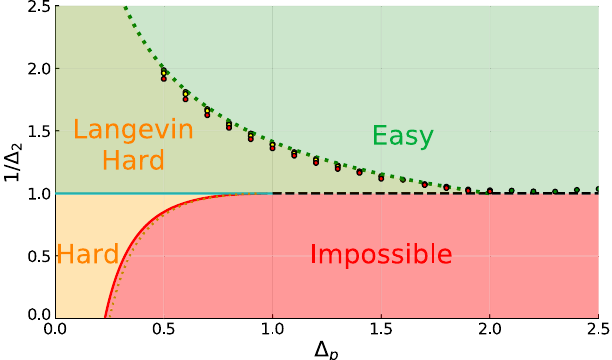
FIG. 15. Estimated divergence point Δ (cid:1) 2 at fixed Δ p ¼ 3 a function of the initial condition 10 − 4 . The vertical axis is in the linear scale, while the horizontal axis is in the log scale. We observe that the dependence of estimated divergence points on the initial condition is consistent with the asymptotic value 1 = Δ (cid:1) 2 ¼ from Eq. (15) and depicted by the dashed line. The dotted line instead represents the AMP threshold, for comparison.